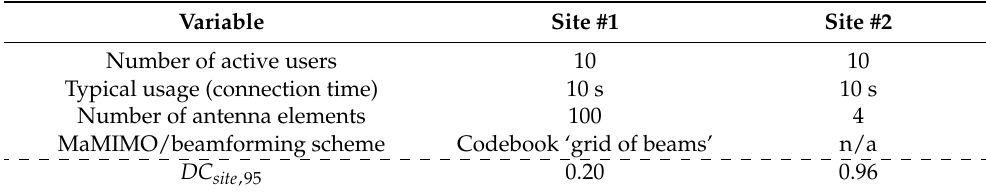
Table 3. Assumptions made in the calculation of the spatiotemporal duty cycles at the two 5G new radio (NR) sites considered in this study [19]. Variable Site #1 Site #2 Number of active users 10 10 Typical usage (connection time) 10 s 10 s Number of antenna elements 100 4 MaMIMO/beamforming scheme Codebook ‘grid of beams’ n/a DC site ,95 0.20